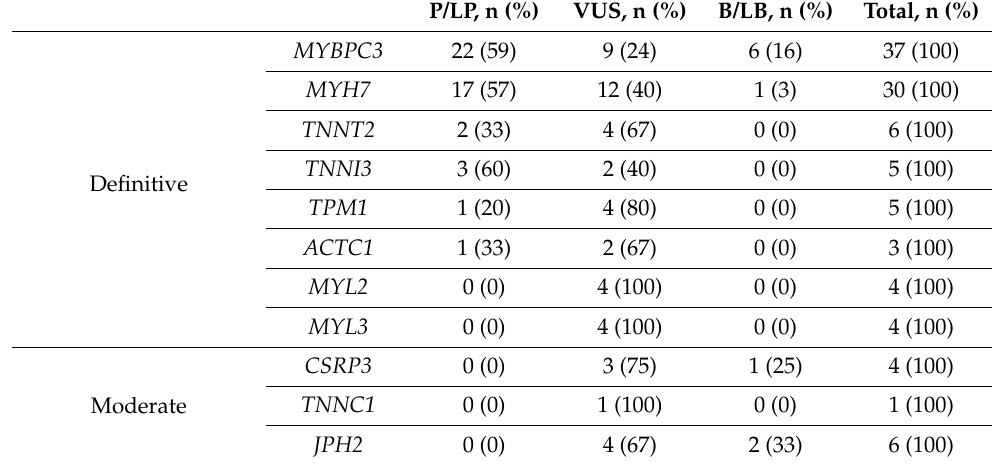
Table 3. Gene-level variant analysis, with the number (n) and the percentage (%) of variants identified in different genes. Definitive: genes with definitive evidence for HCM association; moderate: genes with moderate evidence for HCM association; P/LP: pathogenic/likely pathogenic variant; VUS: variant of unknown significance; B/LB: benign/likely benign variant; LVH: left ventricular hypertrophy.